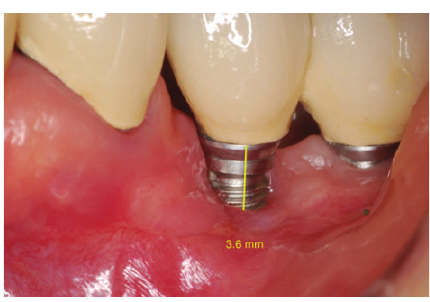
Figure 20: Postoperative aspect 21 days after surgery: note that the masticatory mucosal tissue graft failed to cover exposed threads but gained soft tissue volume.